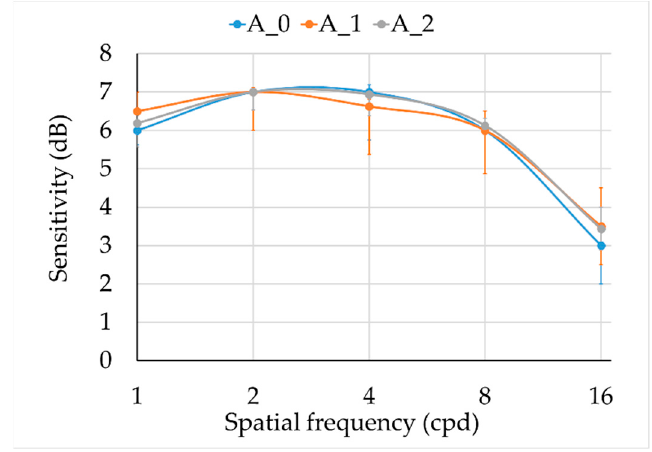
Figure 3. Achromatic monocular CSF. Median and interquartile range for three groups: A_0 = controls (blue), A_1 = moderated smokers (orange), and A_2 = severe smokers (grey). Table 2. Statistic results for the achromatic (A) and chromatic (RG and BY) contrast sensitivity comparison among groups at each frequency.